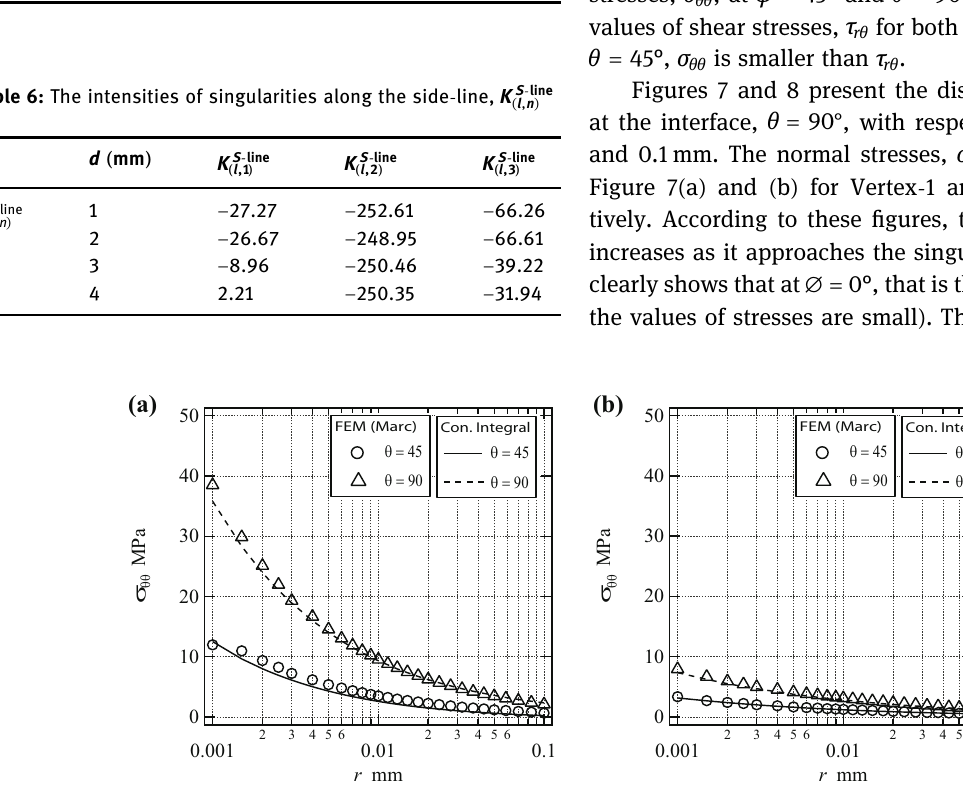
Figure 5: Distribution of normal stresses, σ θθ , at ϕ = 45° and θ = 45° and 90° with respect to r : ( a ) Vertex - 1 and ( b ) Vertex - 2.